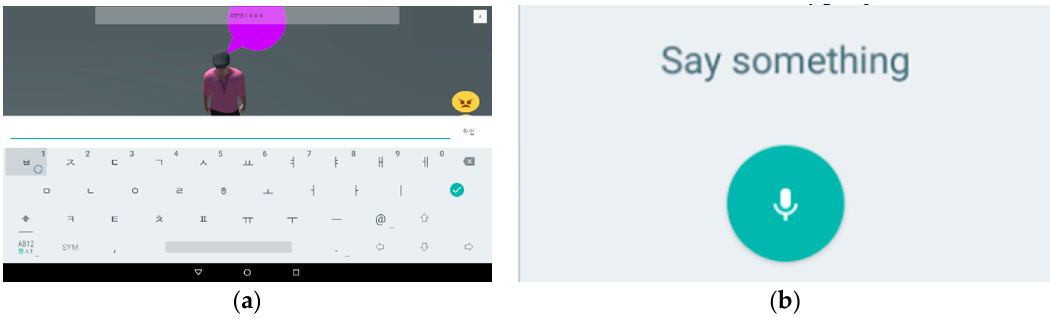
Figure 10. The methods for sending messages in AR messengers; ( a ) is using traditional keystrokes, ( b ) is voice recognition using Google Cloud Speech [30].